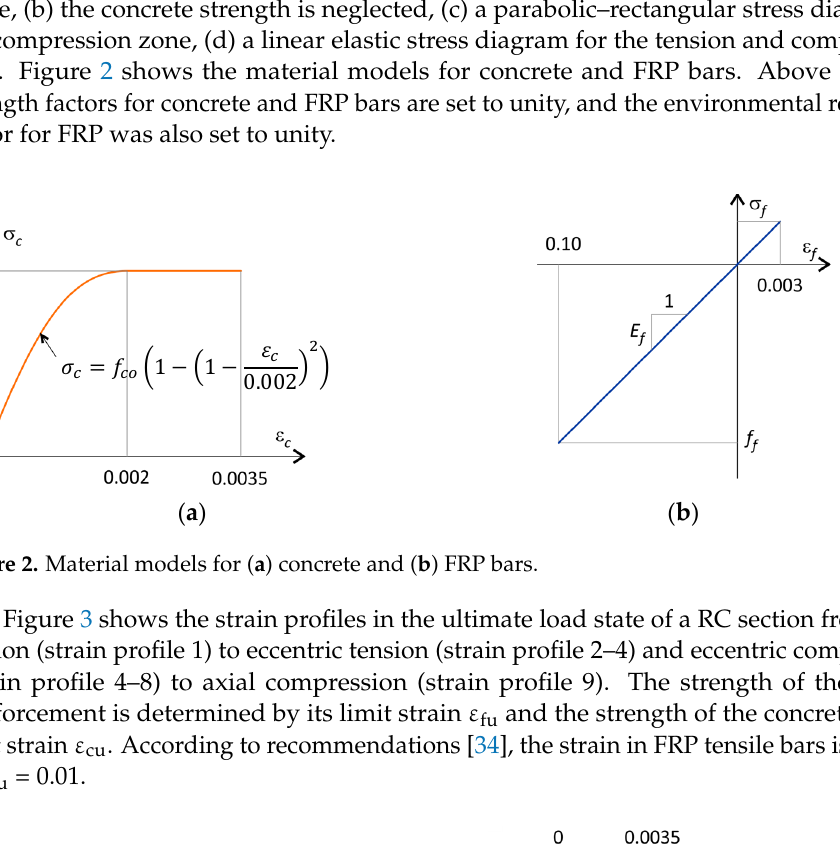
Figure 1. Interaction curves and load paths.